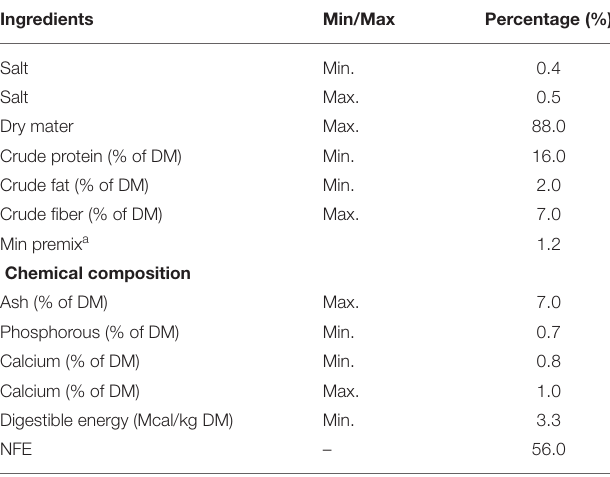
TABLE 1 | Ingredients and chemical composition of